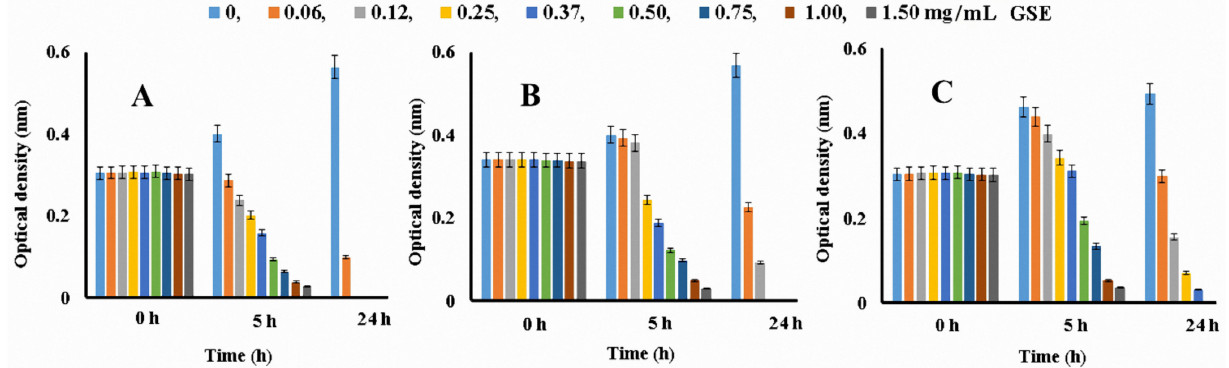
Figure 2. Quantitative evaluation of antibacterial activity of Pinot Noir GSE at different concentrations against ( A ) S. aureus , ( B ) B. cereus , and ( C ) E. coli during incubation at 0, 5, and 24 h ( n = 5).